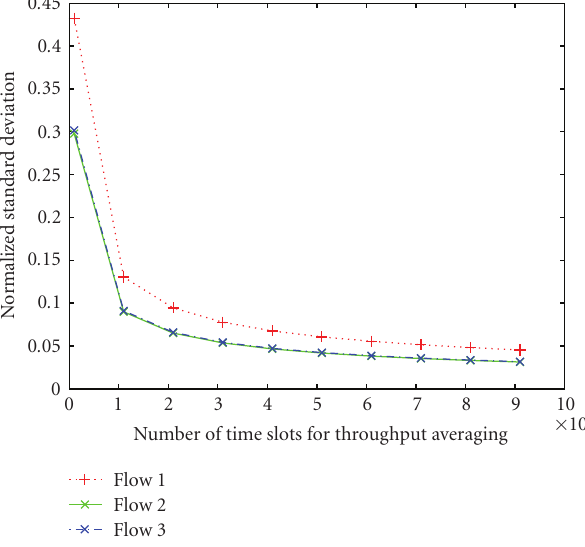
Figure 8: Normalized throughput standard deviation as a function of bu ff er size ( T ).